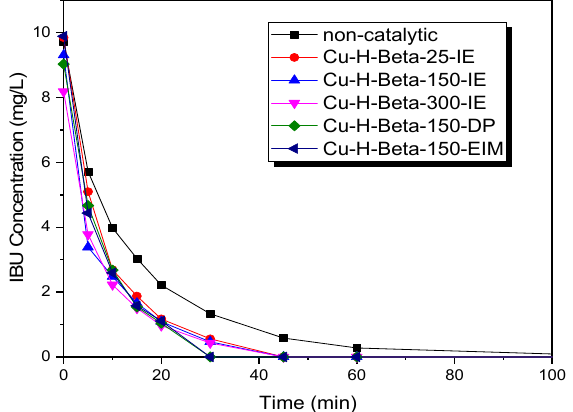
Figure 5. The degradation of IBU via catalytic ozonation in the presence of 2.5 mL/min nitrogen. [IBU] = 10 mg/L, gas flow rate = 452.5 mL/min, T = 20 °C, stirring rate= 1070 rpm.